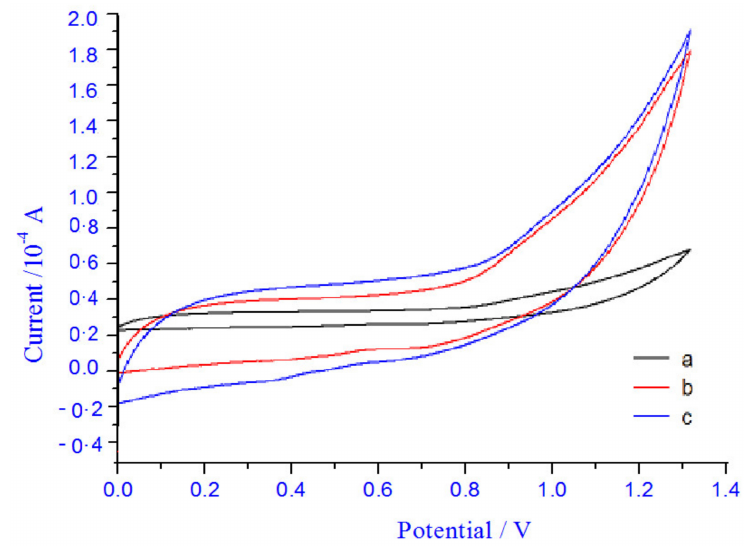
Figure 4. CV recorded at pH of 7.0 in 0.1 M PBS at a scan rate of 50 mVs − 1 ( a ) blank CVs of MWCNT modified GCE ( b ) The bare CVs MWCNT / Cellulose / GCE ( c ) MWCNT / Cellulose / GCE in the presence of